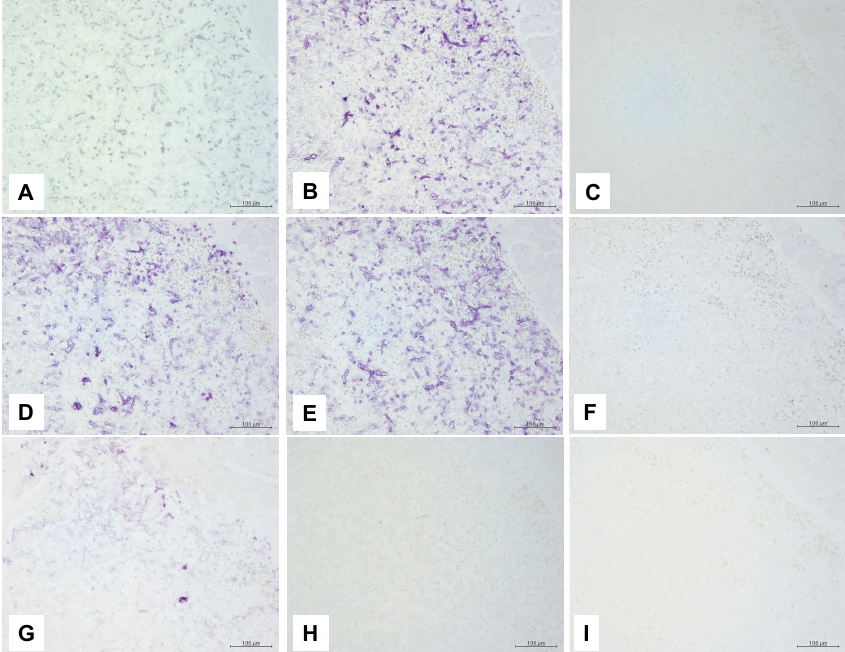
Figure 4. In situ hybridization findings. All the pictures in this figure are taken from the same heart area as IHC presented in Figure 3A–D. ( A ) Positive reaction for PNA panfungal probe. Dark brown pigmentation attributable to diaminobenzidine staining is present in line with hyphae. ( B ) Positive reaction for 18S rRNA panfungal probe. Purple pigmentation attributable to alkaline phosphatase staining is present in line with hyphae. ( C ) No reaction is observed for the oligonucleotide DNA panfungal probe. ( D ) Positive reaction for the 18S r RNA mucormycosis probe. Purple pigmentation attributable to alkaline phosphatase staining is present in line with hyphae. ( E ) Positive reaction for the 28S r RNA mucormycosis probe. ( F ) Negative reaction for the probe targeting alkaline protein- ase of Aspergillus fumigatus . ( G ) Positive reaction for the oligonucleotide DNA probe targeting Cun- ninghamella spp. The positive signal is weaker than those of two mucormycosis probes ( A – B ). ( H ) Negative reaction for the oligonucleotide DNA probe targeting Absida spp. ( I ) Negative reaction for the oligonucleotide DNA probe targeting Mucor spp., Rhizomucor spp., Rhizopus spp., and Saksenaea spp. Magnification of all pictures are (200×).